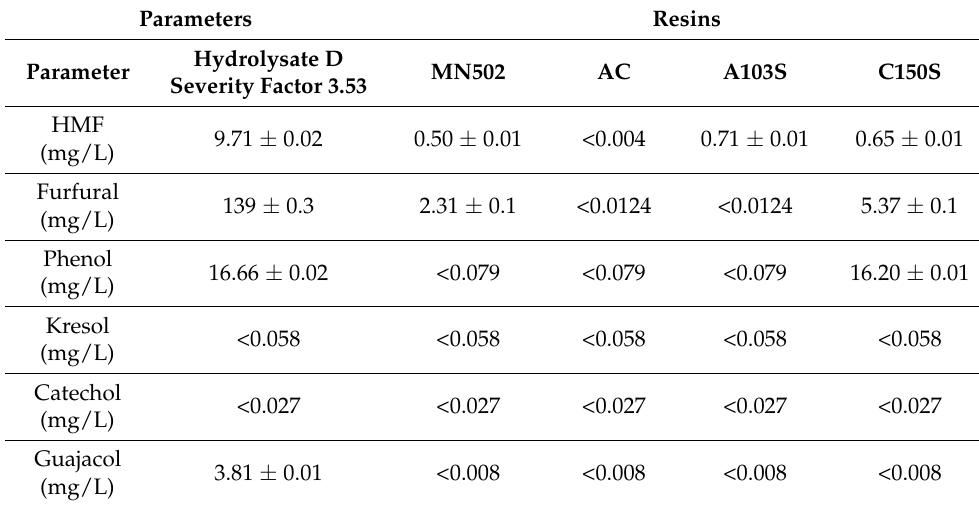
Table 6. Removal of furfural, HMF and phenols after the down-streaming process.